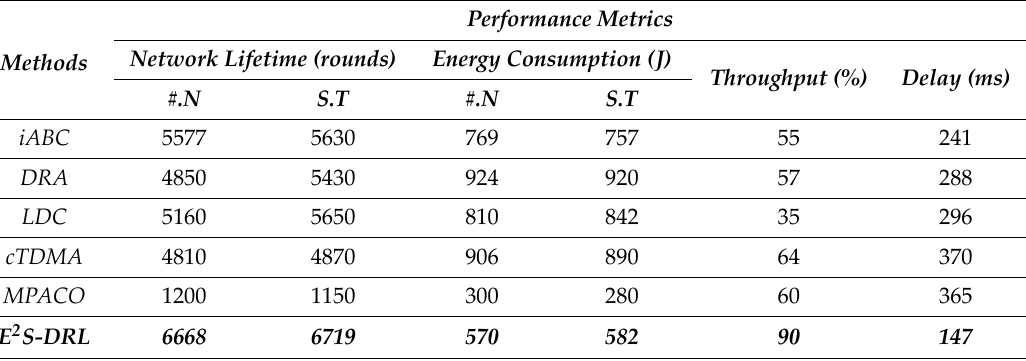
Table 5. Numerical results of proposed